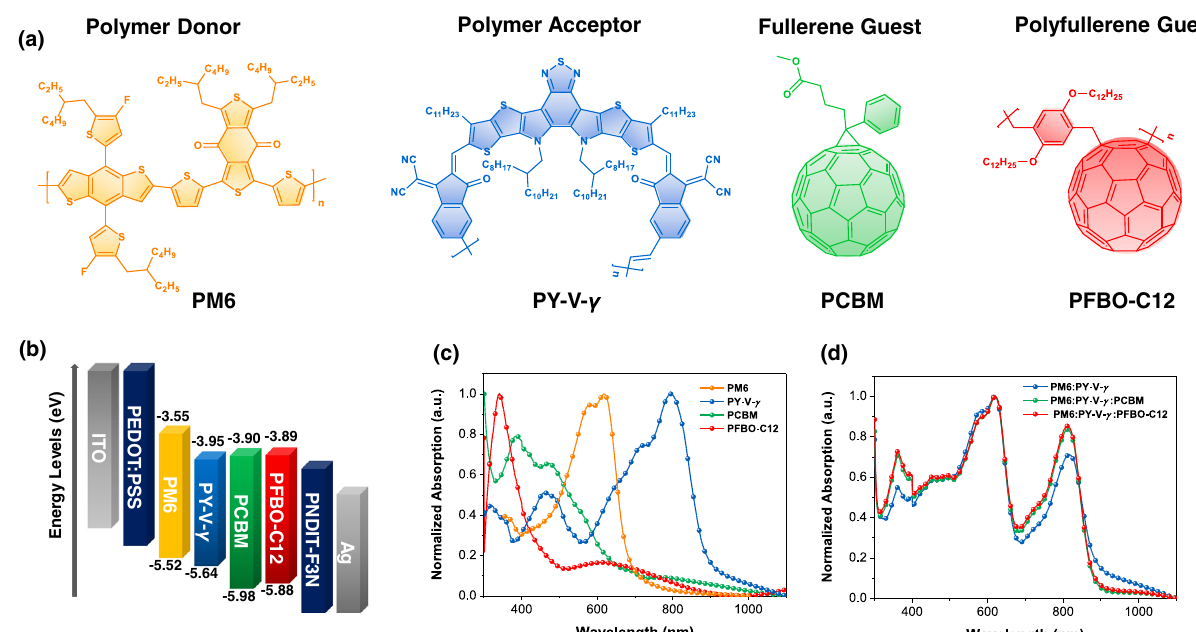
Fig. 1 | Materials and optoelectronic characterization. a Chemical structures of PM6 (polymer donor), PY-V- γ (polymer acceptor), PCBM (fullerene guest), and PFBO-C12 (polyfullerene guest). b Architecture and energy alignment of the